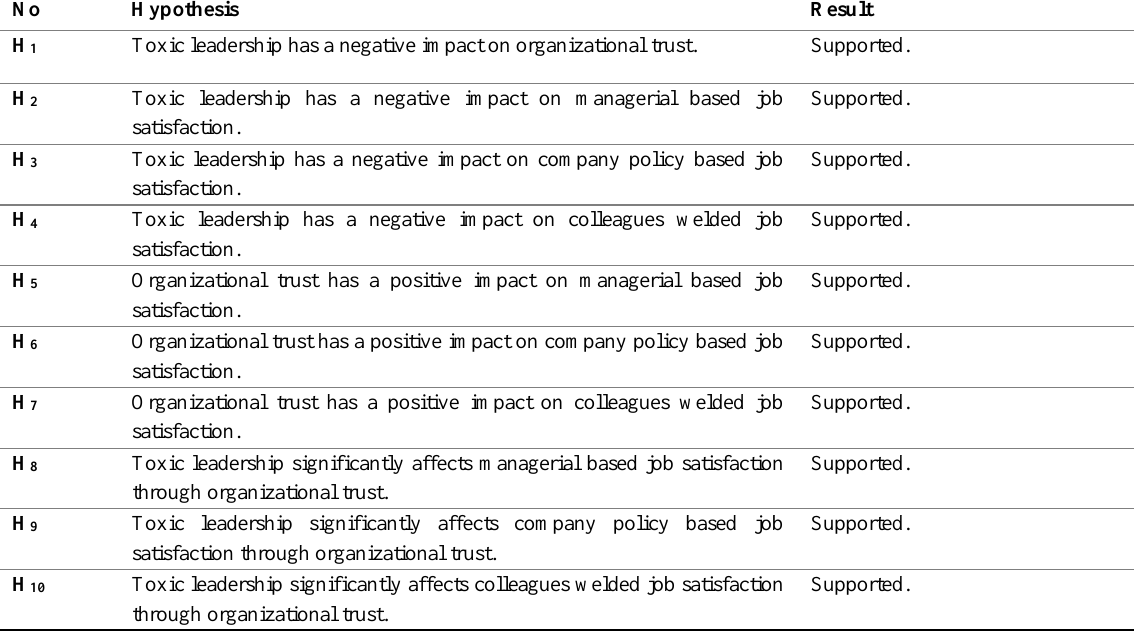
Table 9: Research Hypotheses and